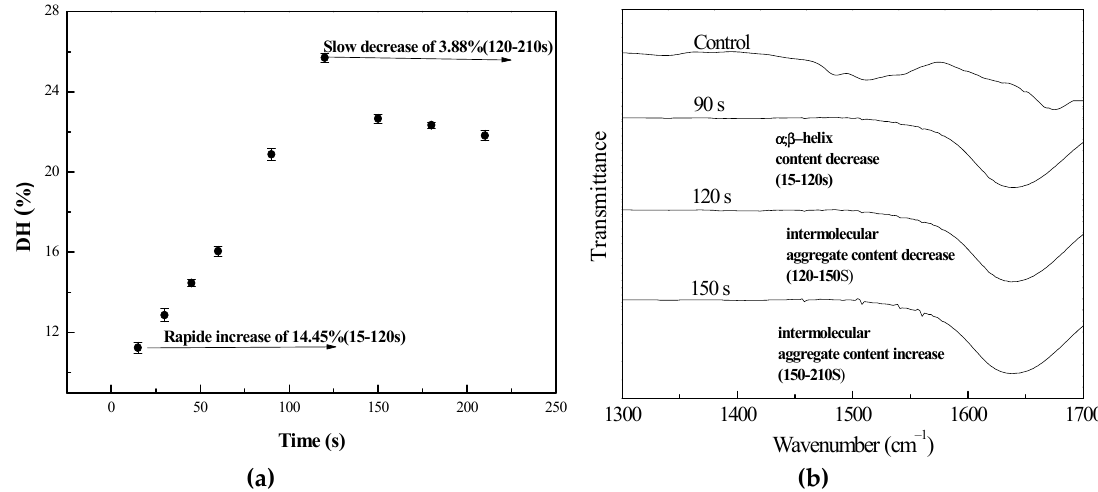
Figure 2. Influence of microwave irradiation time on ( a ) DH and ( b ) the conformation of the lotus protein during enzyme hydrolysis.